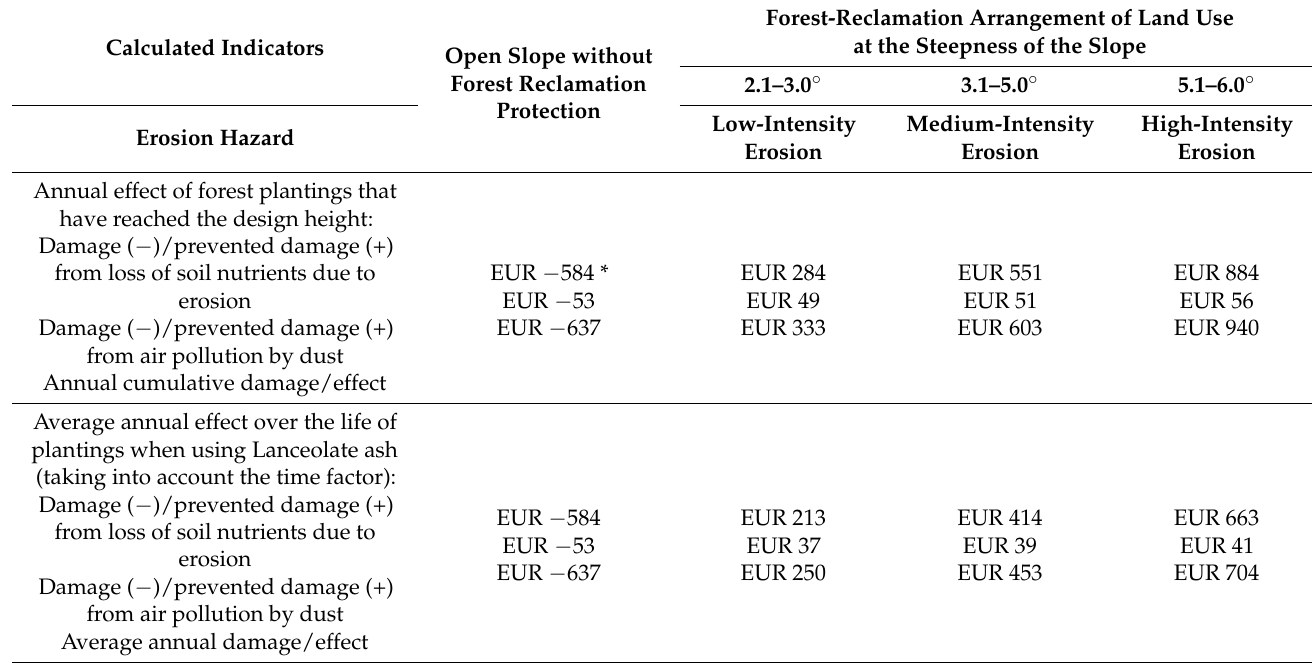
Table 3. Ecological and economic effect obtained due to the forest management of land use on sloping plots (per ha of forested land